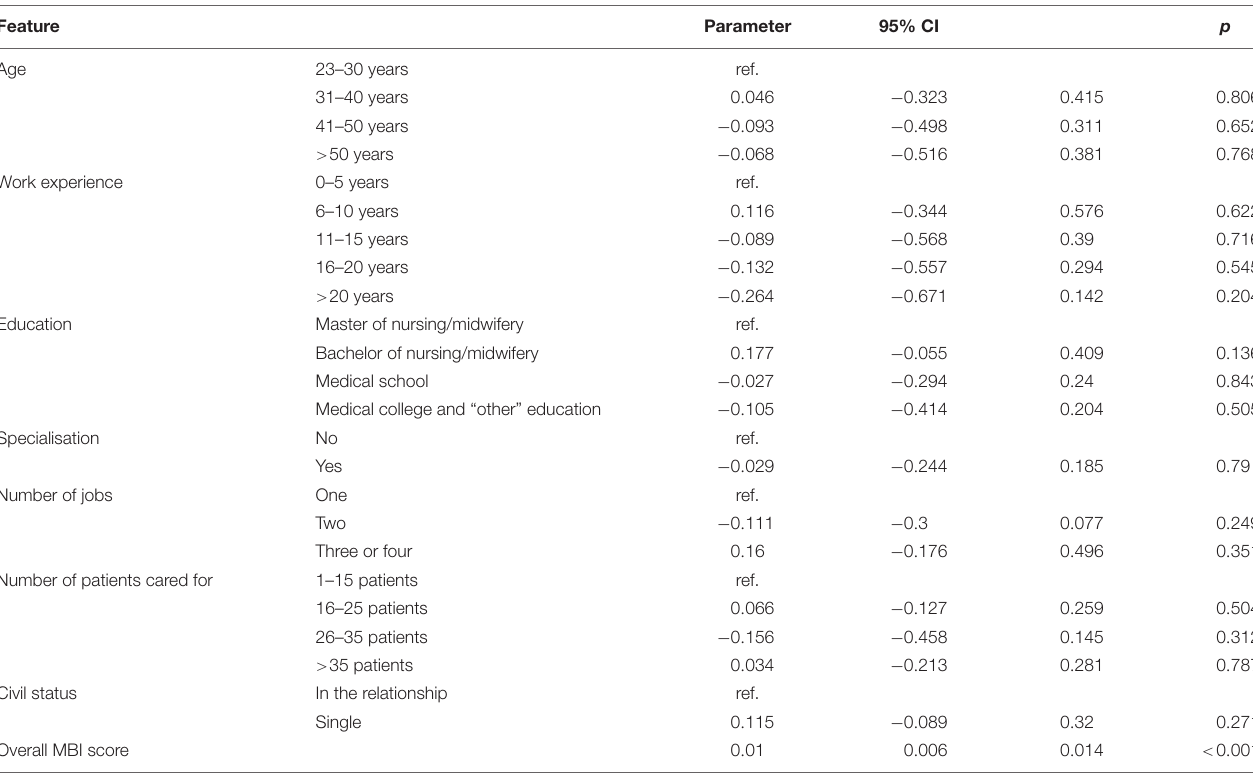
TABLE 5 | Multiple regression model of nursing care rationing for the overall MBI score.